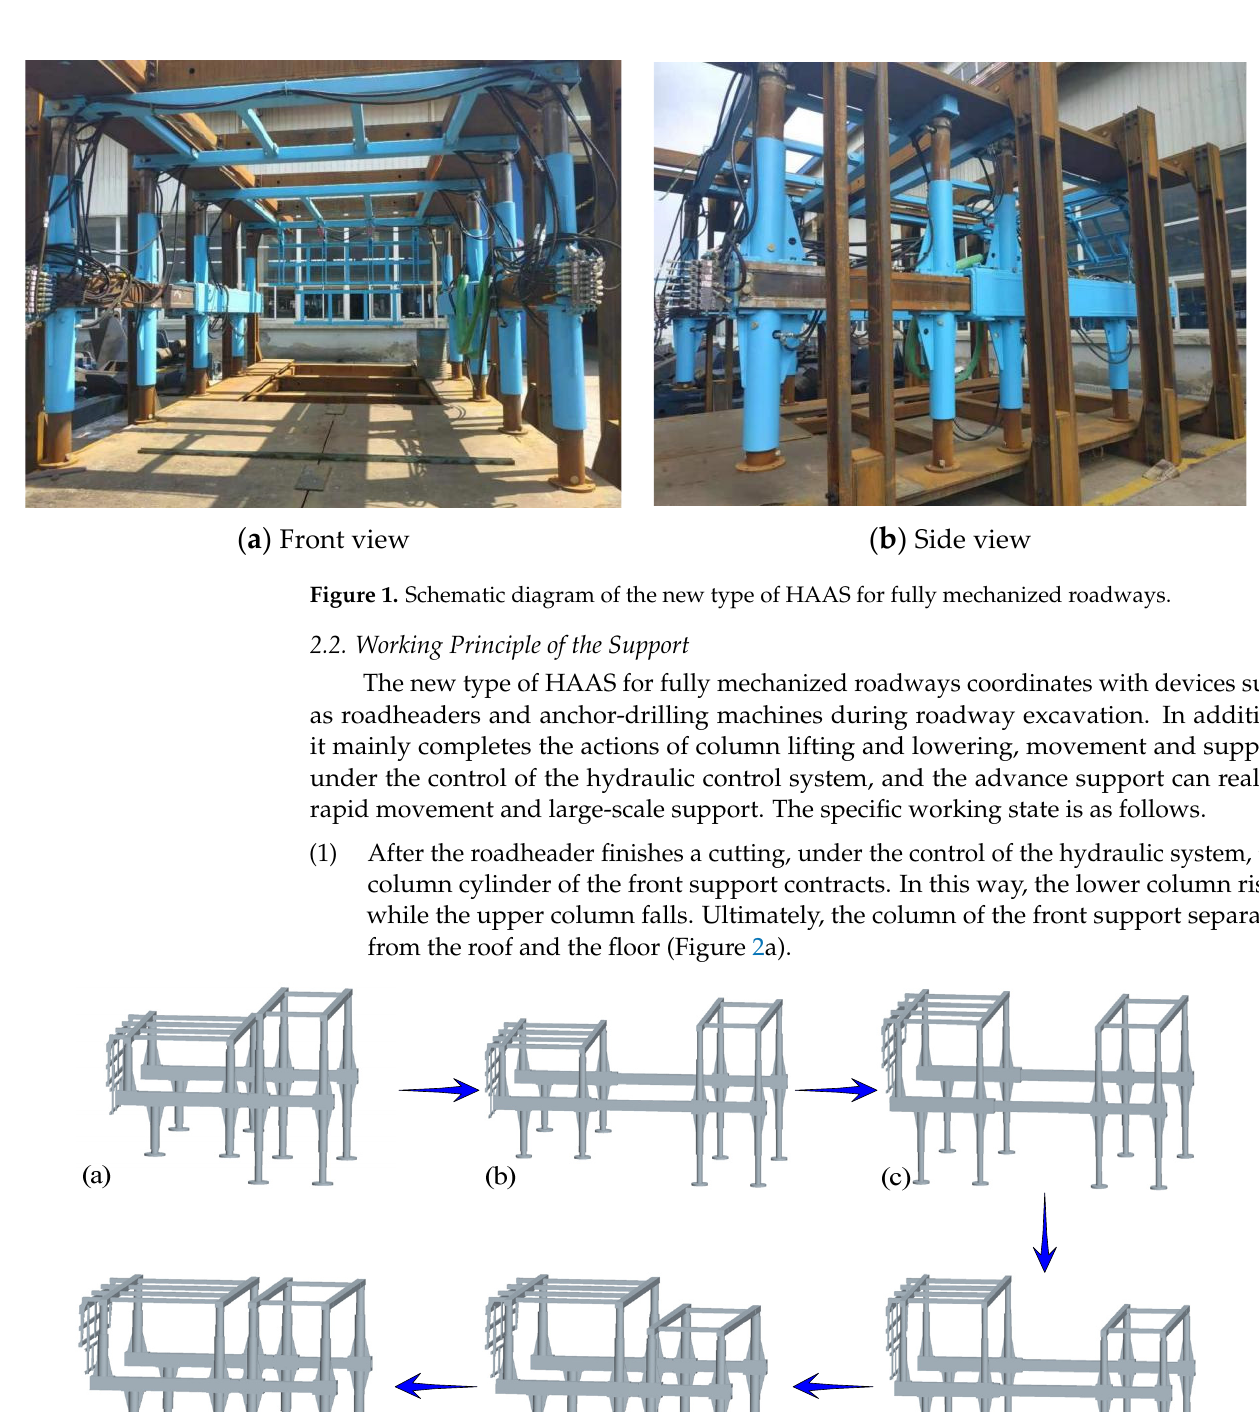
Figure 2. Working process of the new type of HAAS for fully mechanized roadways. ( a ) Support preparation; (b ) Front support movement; ( c ) Front support expansion; ( d ) Rear support retracted; ( e ) Rear support movement; ( f ) Rear support expansion.